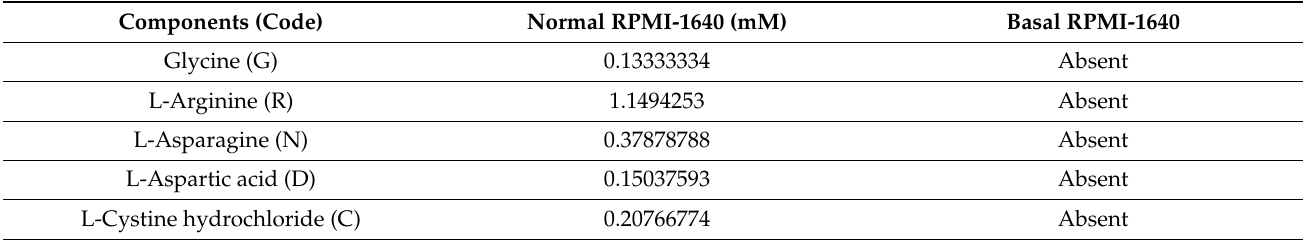
Table A1. Components of control and basal RPMI media allowing for comparison of